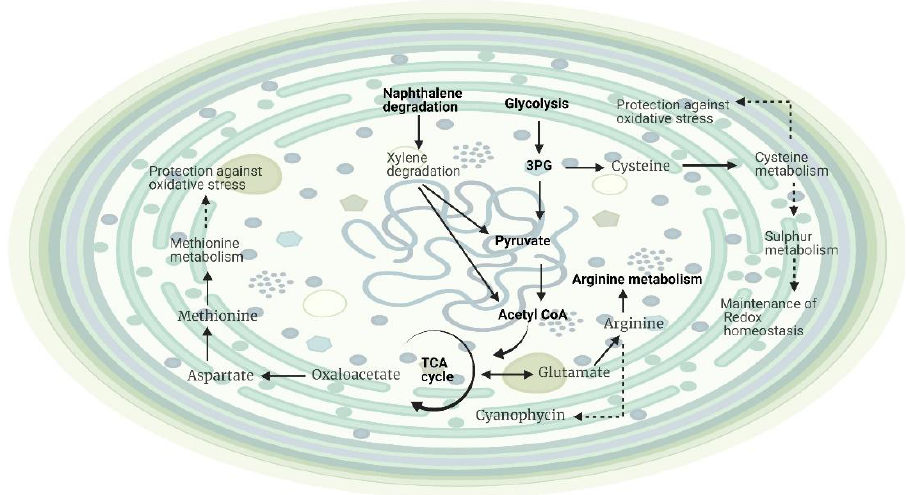
Figure 4. Cellular model representing the effects of temperature on the metabolic activities of Planktothricoides sp. (SR001) based on metabolic profiling. The metabolites corresponding to pathways shown in the grey color were partially identified. Created with BioRender.com (accessed on 4 August 2021).